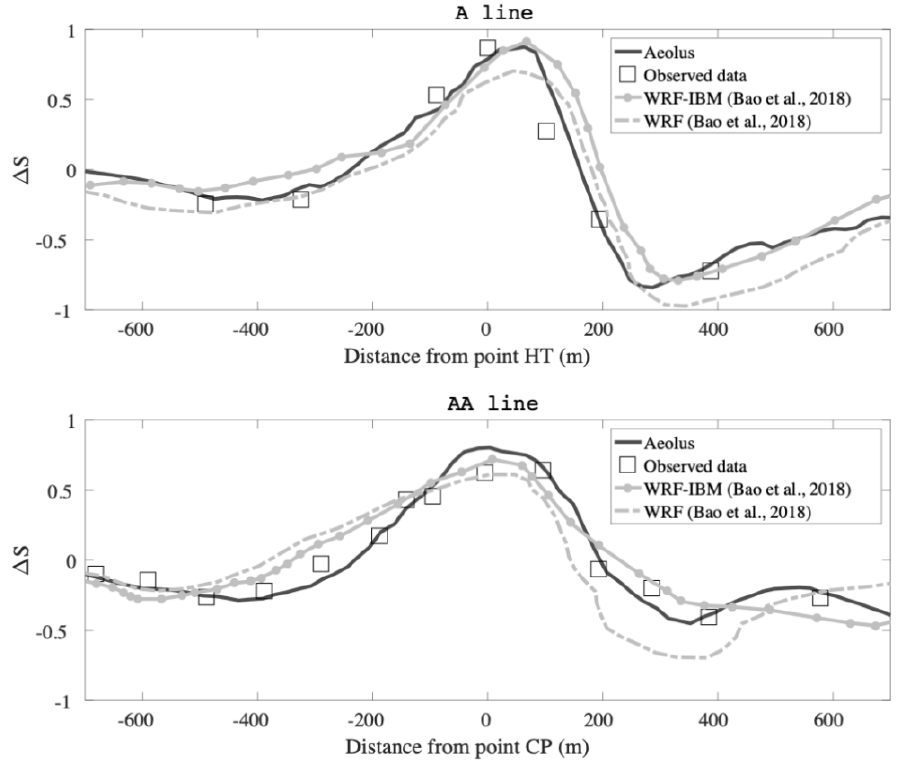
Figure 5. Comparison of fractional speedup predicted by Aeolus along lines A ( top ) and AA ( bottom ) with field campaign data as well as other peer ‐ reviewed models.